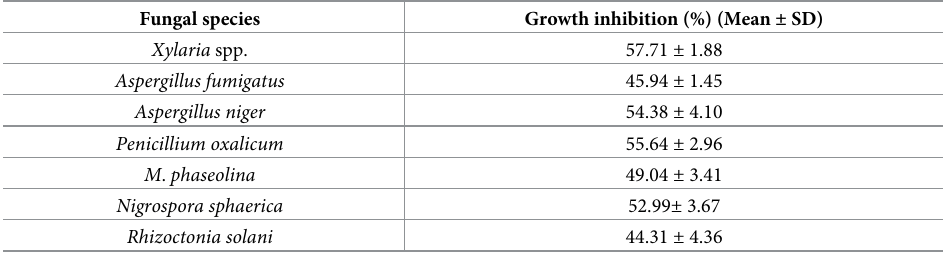
Table 3. Growth inhibition induced by B . contaminans NZ on different plant pathogenic